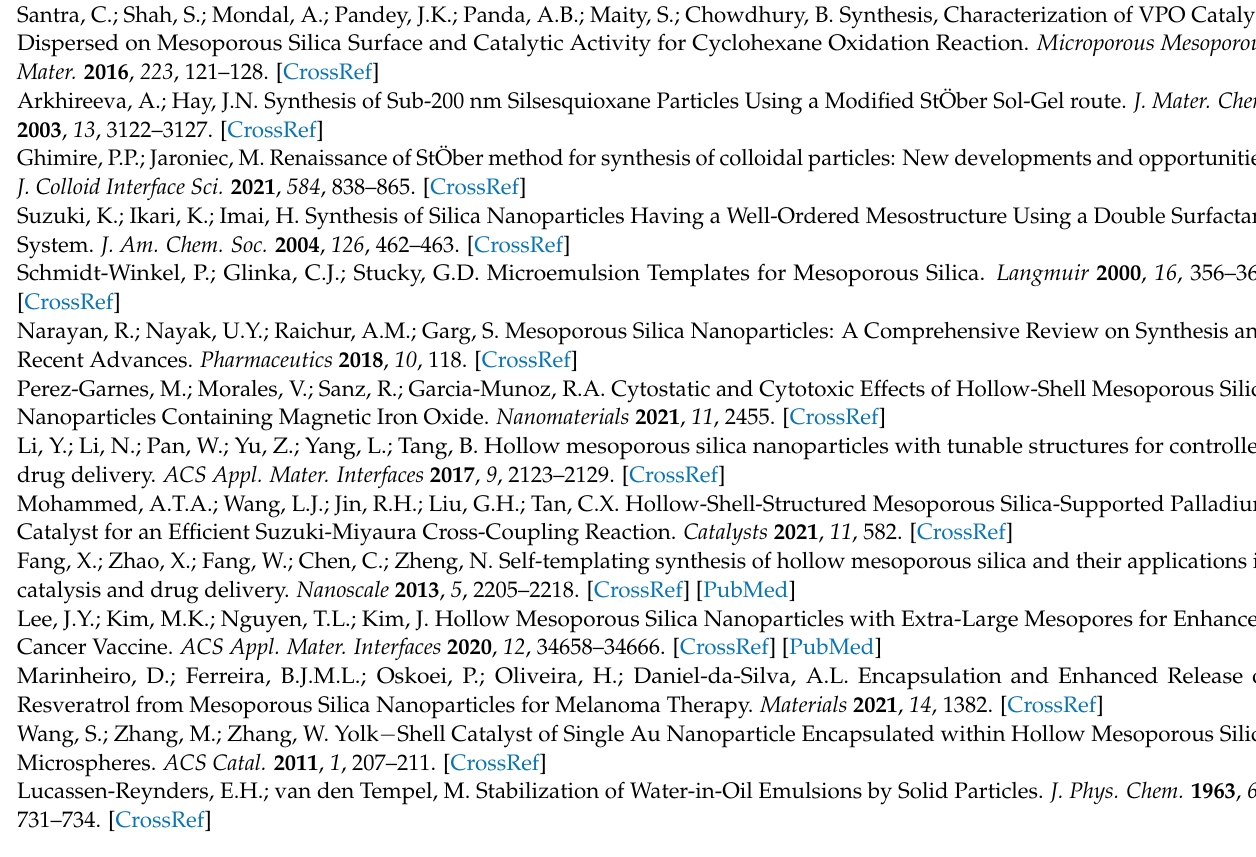
1 and PHMS-2, Figure S2: Hot filtration test, Figure S3: Catalyst recyclability test of the catalyst, Figure S4: Small-angle PXRD of the catalyst after 4th cycle, Figure S5: 1 H-NMR spectrum of 5- hydroxymethylfurfural (5-HMF) and Figure S6: UV-Vis spectrum of 5-HMF formation from